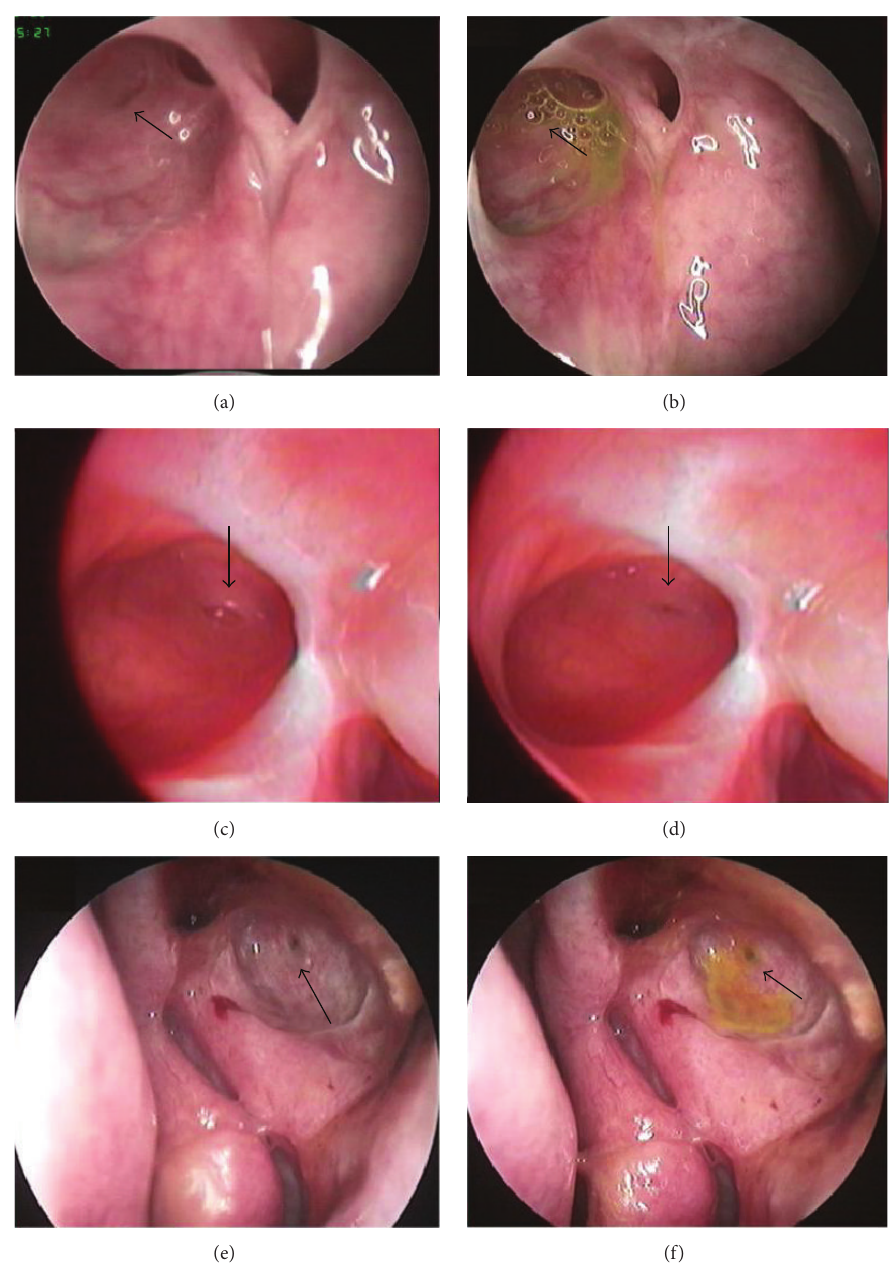
Figure 1: Observation of the mucosal folds in the EE-DCR patients. (a) and (b) show anterior mucosal folds (right nose and black arrow) with and without a fluorescein appearance test (the latter also with a few air bubbles). (c) displays an upper mucosal fold (right nose) with an open orifice in a circle area (black arrow) during the eyelid closing, and (d) displays an incompletely closed orifice (right nose and black arrow) during the eyelid opening. (e) and (f) display the orifices (left nose) without remarkable mucosal folds (the latter with a positive fluorescein appearance